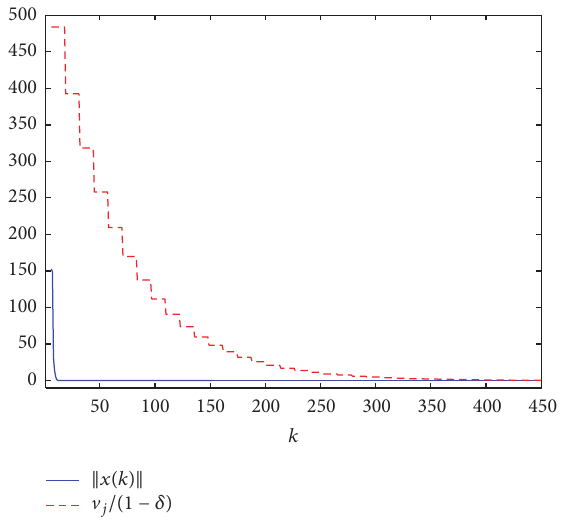
Figure 4: Unsaturation of the quantizer when 𝑁 = 60 under method I.